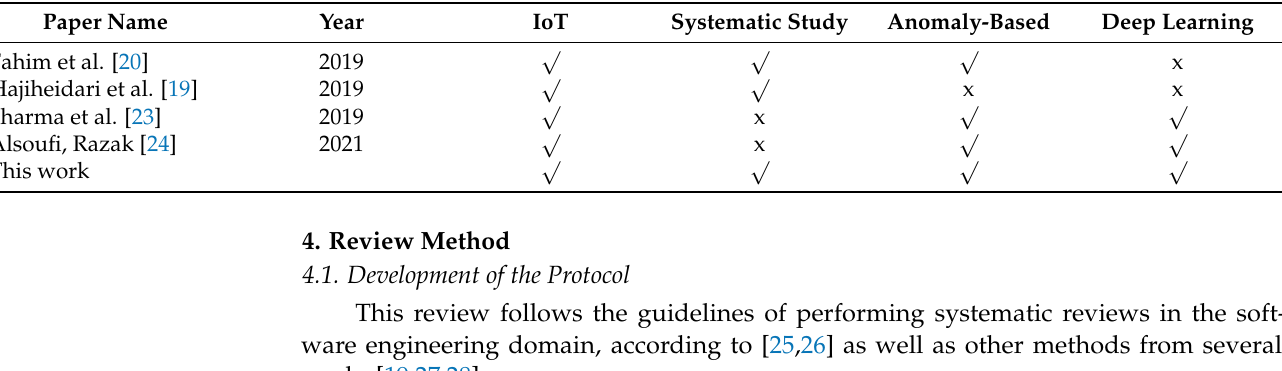
Table 1. Comparison with other similar review articles in the area: (